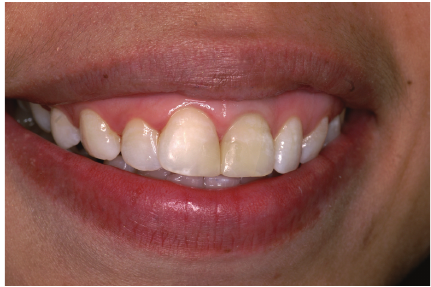
Figure 16: Stability of the result at 2